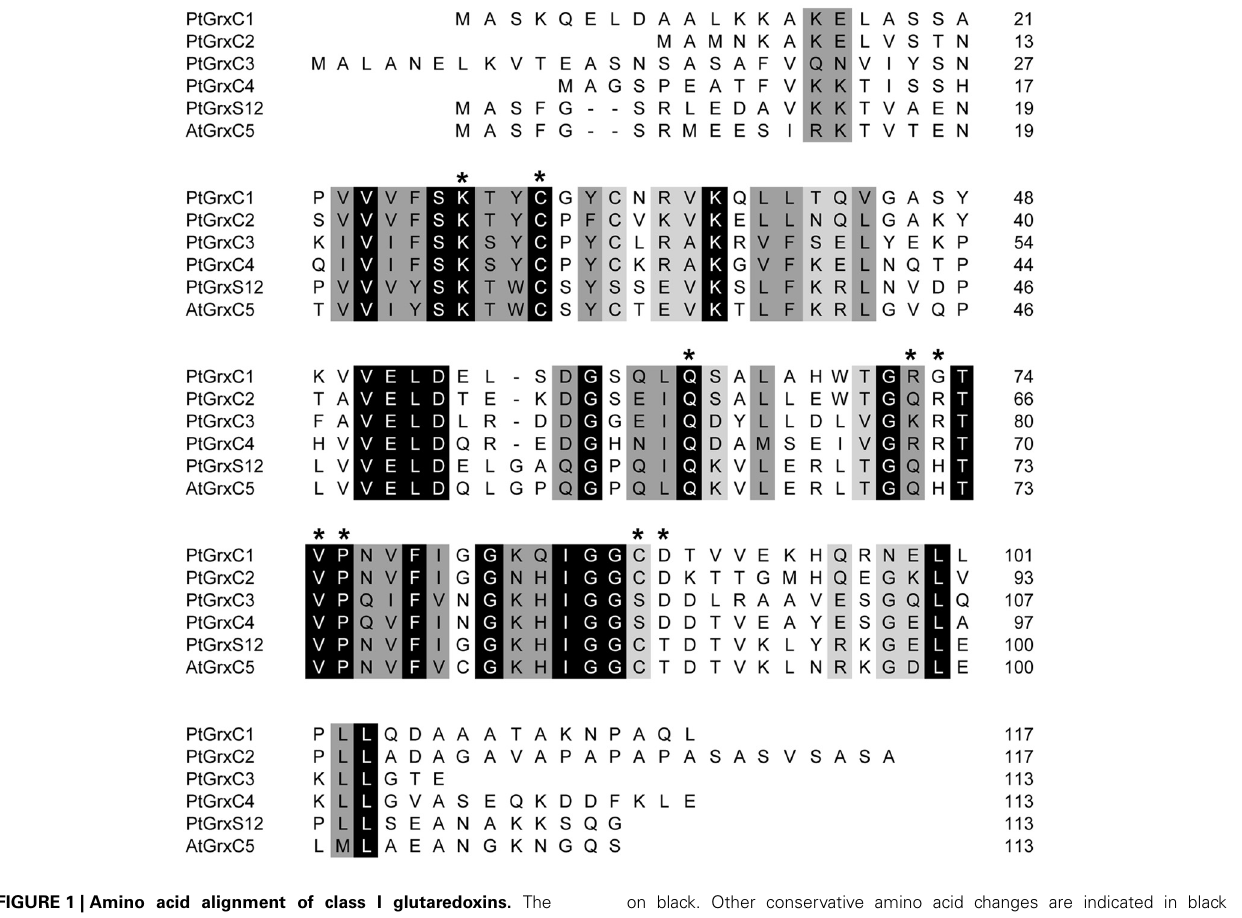
FIGURE 1 | Amino acid alignment of class I glutaredoxins. The alignment was done using ClustalW from sequences of the recombinant proteins that are deprived of putative targeting sequences. The strictly conserved amino acids are depicted in white